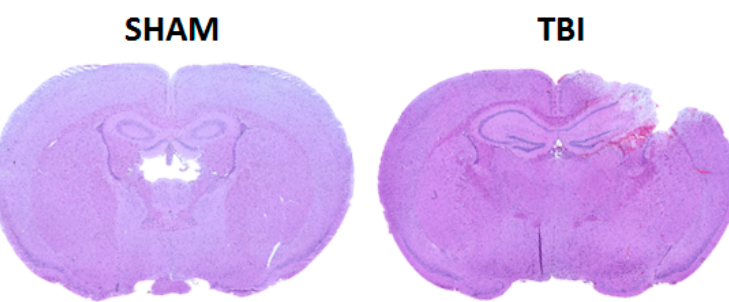
Figure 1. Representative cresyl violet-stained coronal brain sections from sham and TBI mice at 48 h.